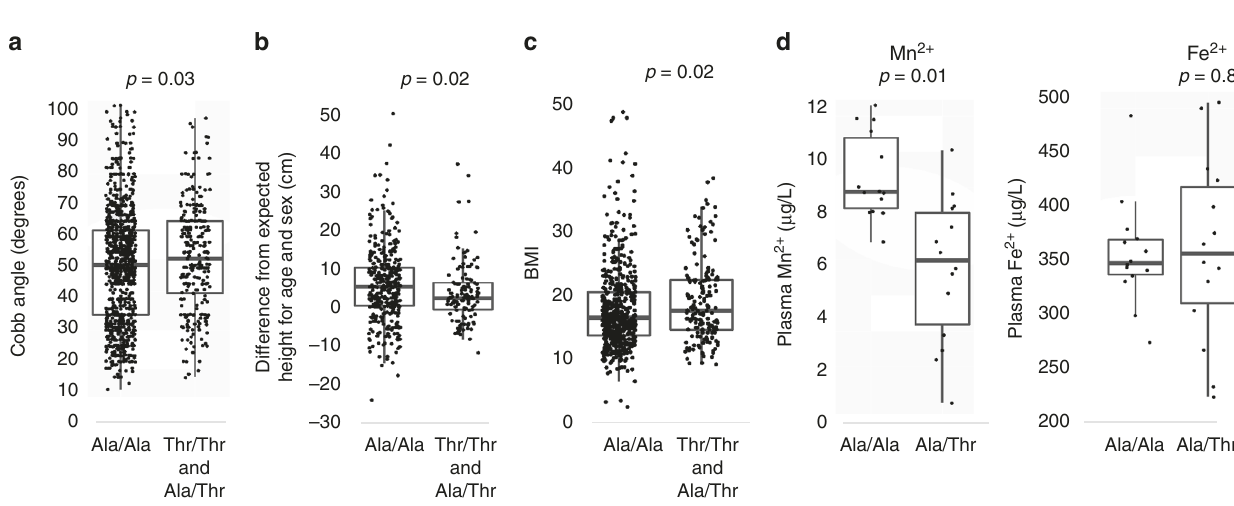
Fig. 2 Clinical characteristics of AIS cases with different rs13107325 genotypes. Comparison of a scoliosis curve severity (Cobb angle), b height, c body- mass index, and d plasma manganese and iron levels in AIS patients who are carriers of the SLC39A8 391T allele compared to AIS cases who are non- carriers. For Cobb angle, Ala/Ala ( N = 940) were compared to the combined Ala/Thr ( N = 242) and Thr/Thr ( N = 26). For height, Ala/Ala ( N = 361) were compared to the combined Ala/Thr and Thr/Thr carriers ( N = 123). For plasma manganese and iron, only Ala/Ala ( N = 14) and Ala/Thr ( N = 14) were measured due to lack of plasma samples from Thr/Thr carriers. Lines are median, 1st and 3rd quartiles. Error bars are 95% con fi dence intervals. All comparisons were performed using t -tests